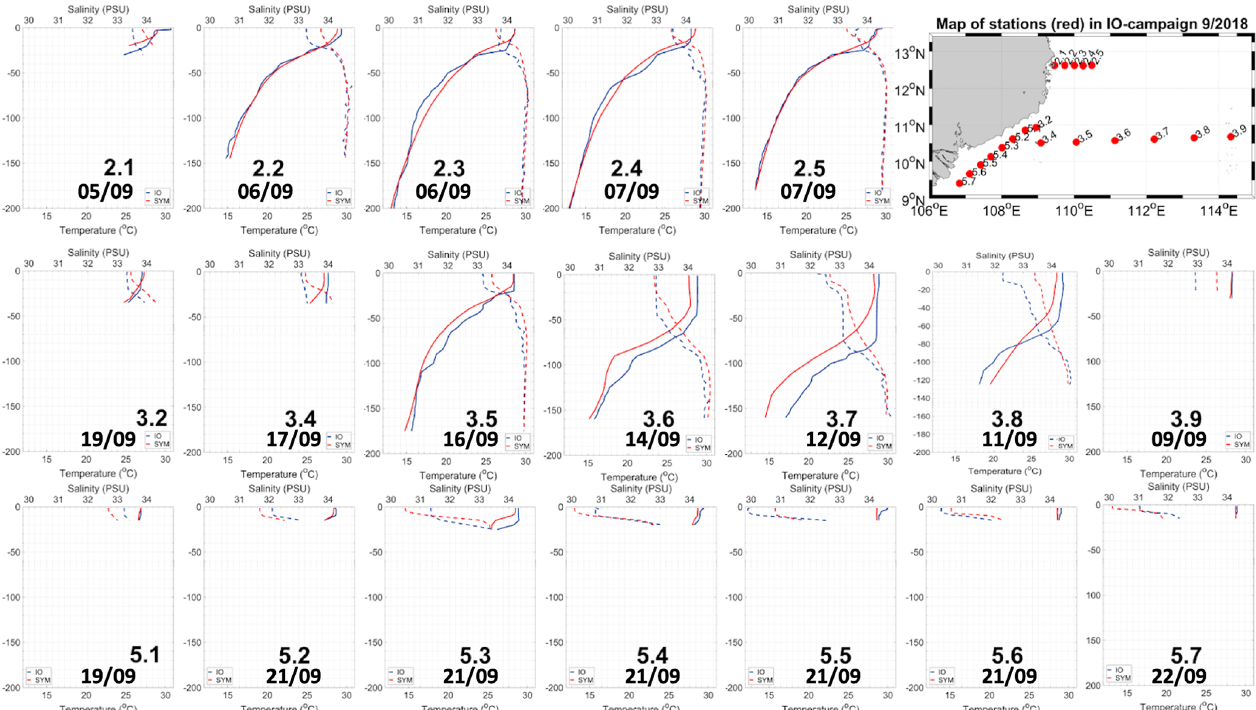
Figure 10. Temperature ( ◦ C) and salinity profiles sampled during IO-18 campaign (blue) and simulated by SYMPHONIE (red) between 12 and 25 September 2018. The station and day of sampling are indicated for each